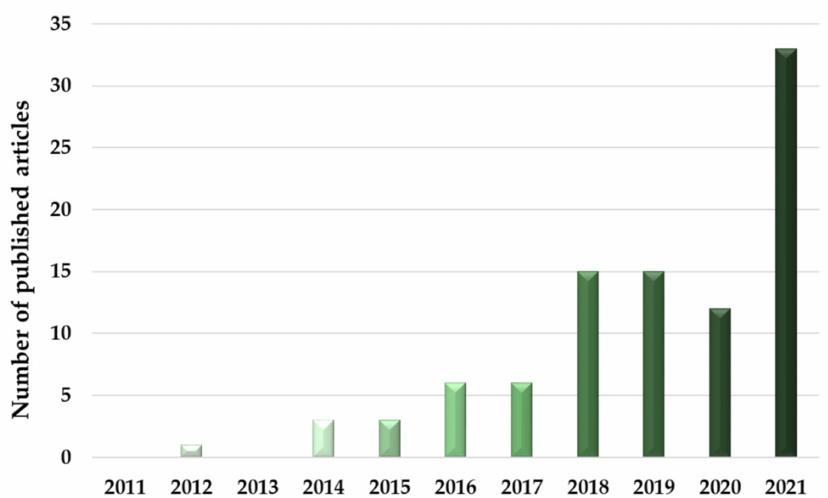
Figure 2. The number of published scientific articles about the cold plasma effects on seeds during 2011–2021 in PubMed.